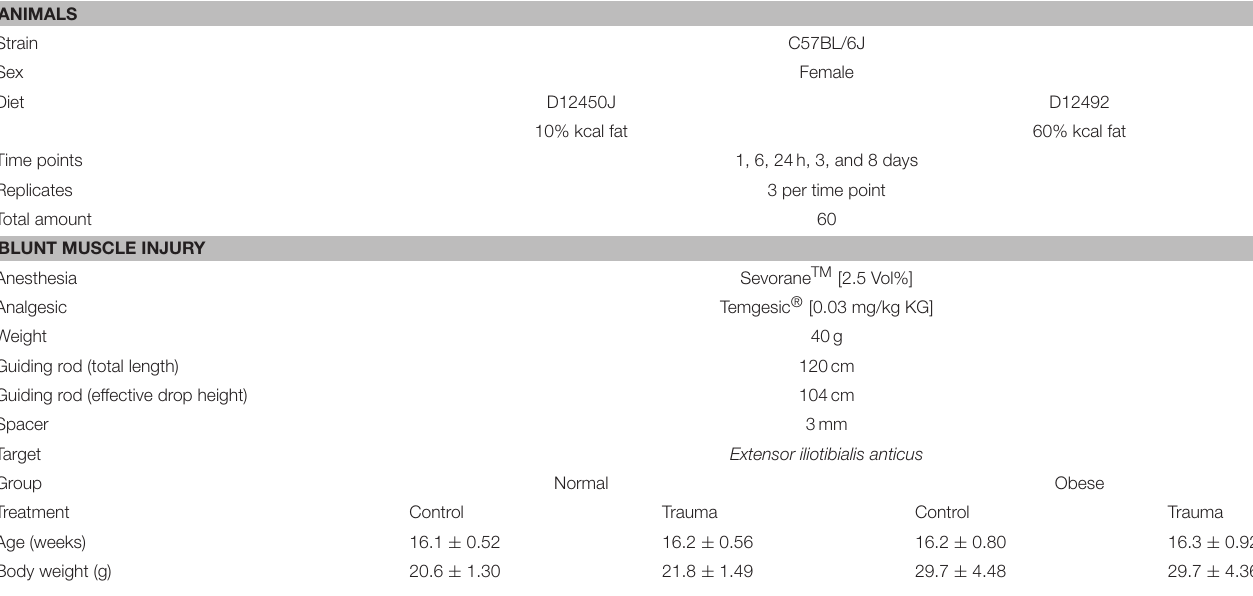
TABLE 1 | Characteristics of C57BL/6J mice and for the induction of a blunt muscle injury.